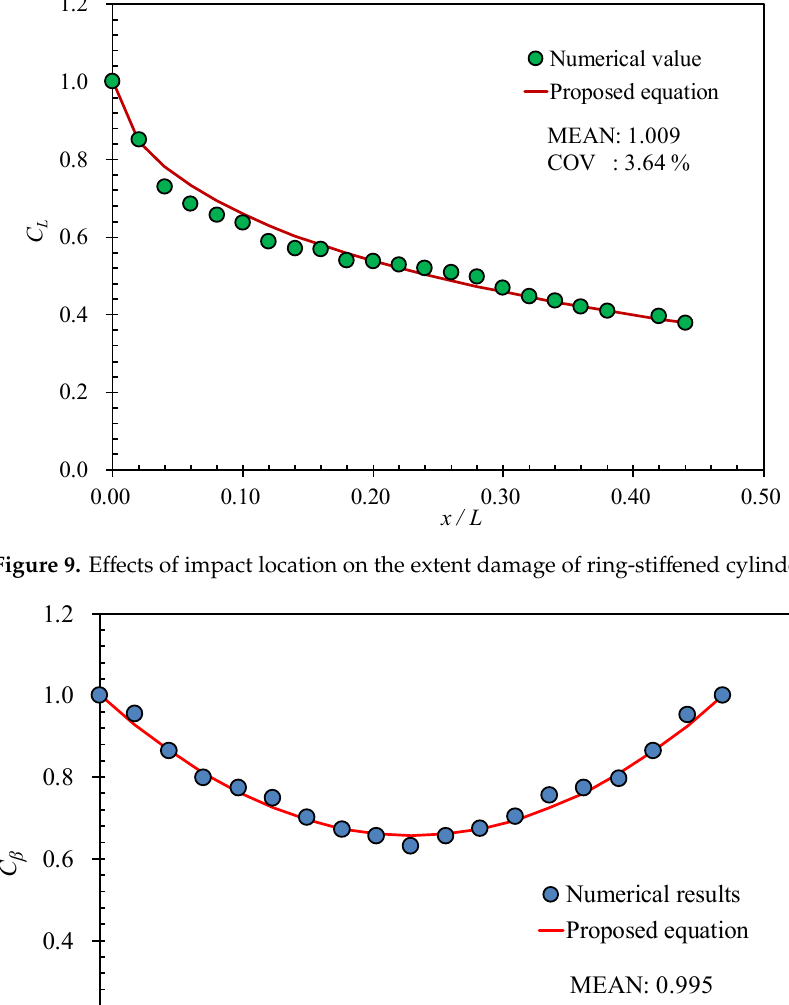
Figure 9. Effects of impact location on the extent damage of ring-stiffened cylinder.